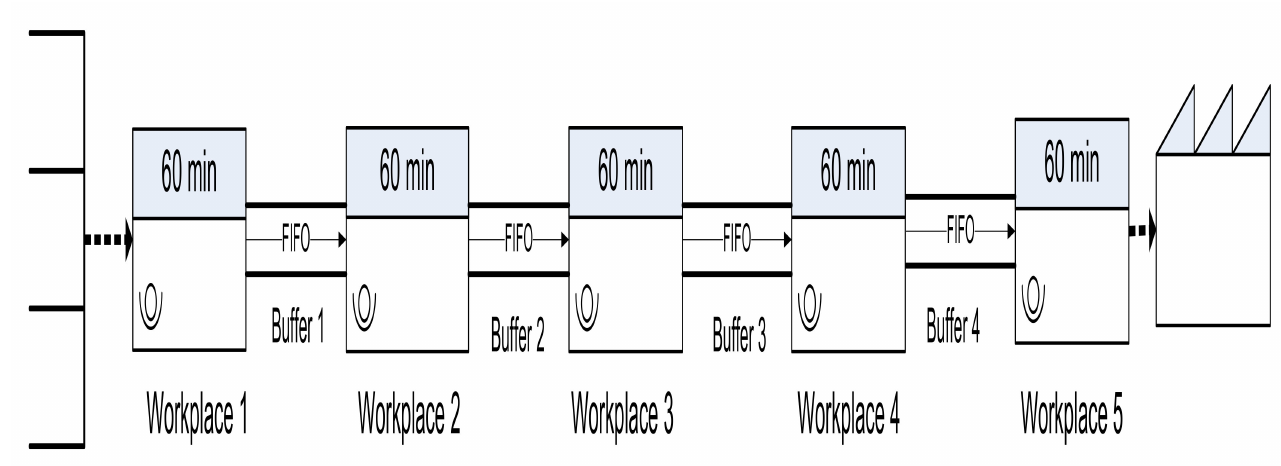
Figure 3. Production